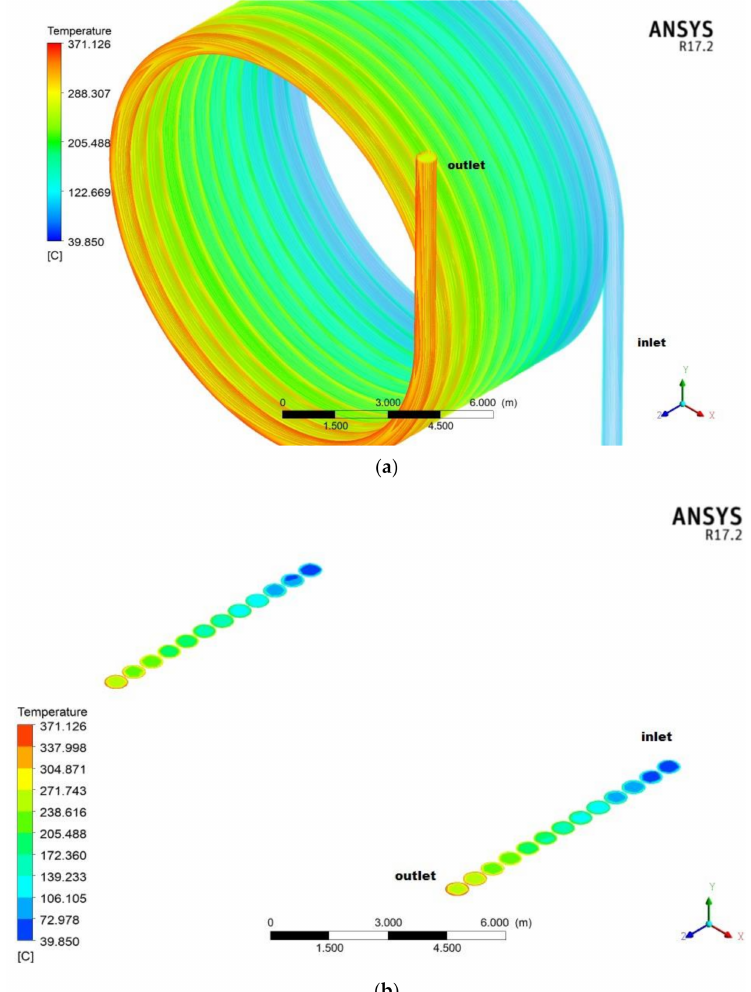
Figure 12. Model of the steam formation process in the coil: ( a ) change in the flow temperature of the water-steam mixture in the steam generator coil along the flow path, ( b ) section of the coil with a moving steam-water mixture (scaling relative to the drawing ( a